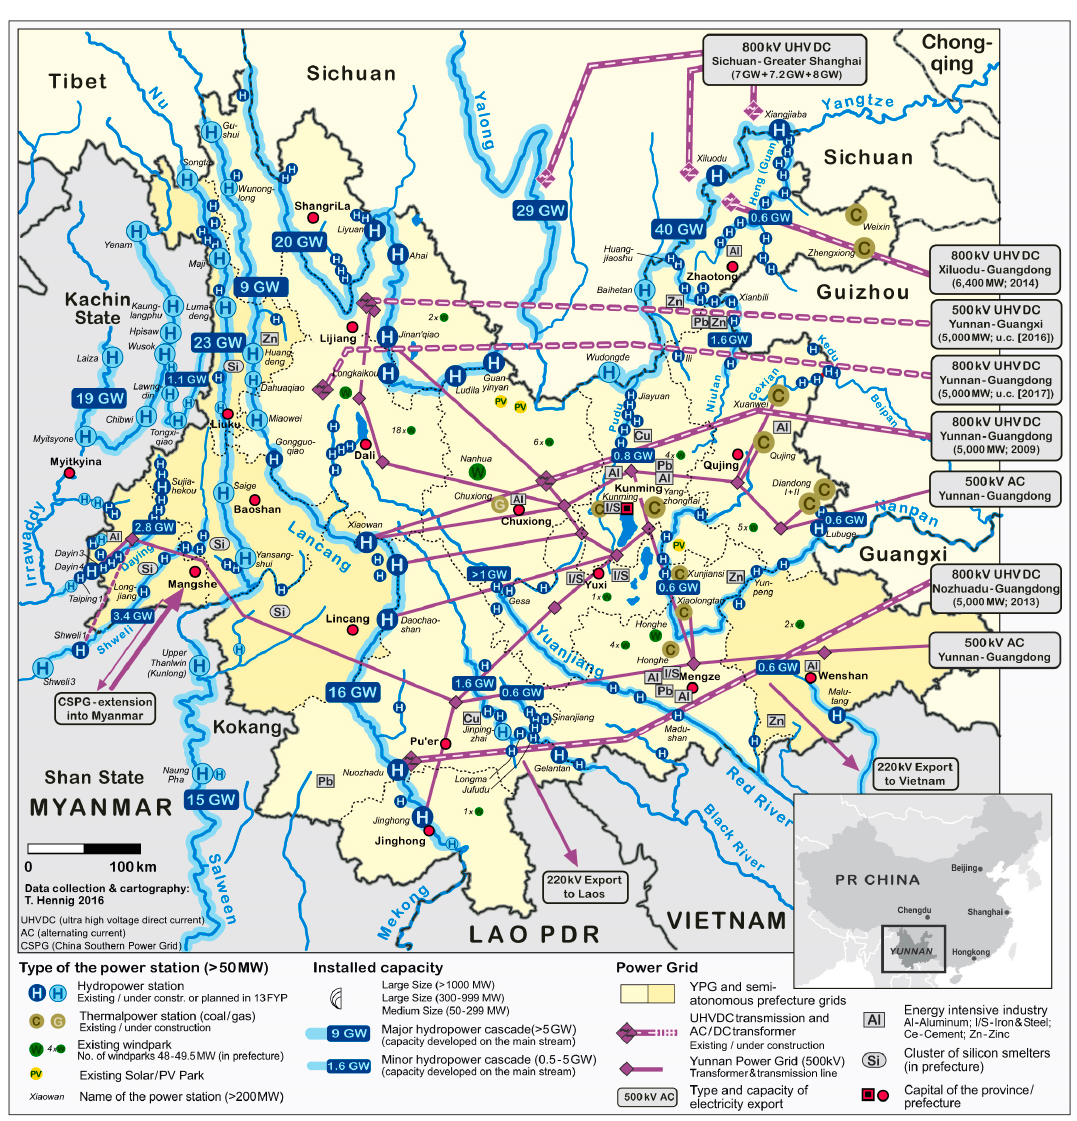
Figure 6. Status quo of Yunnan’s power sector in 2015.